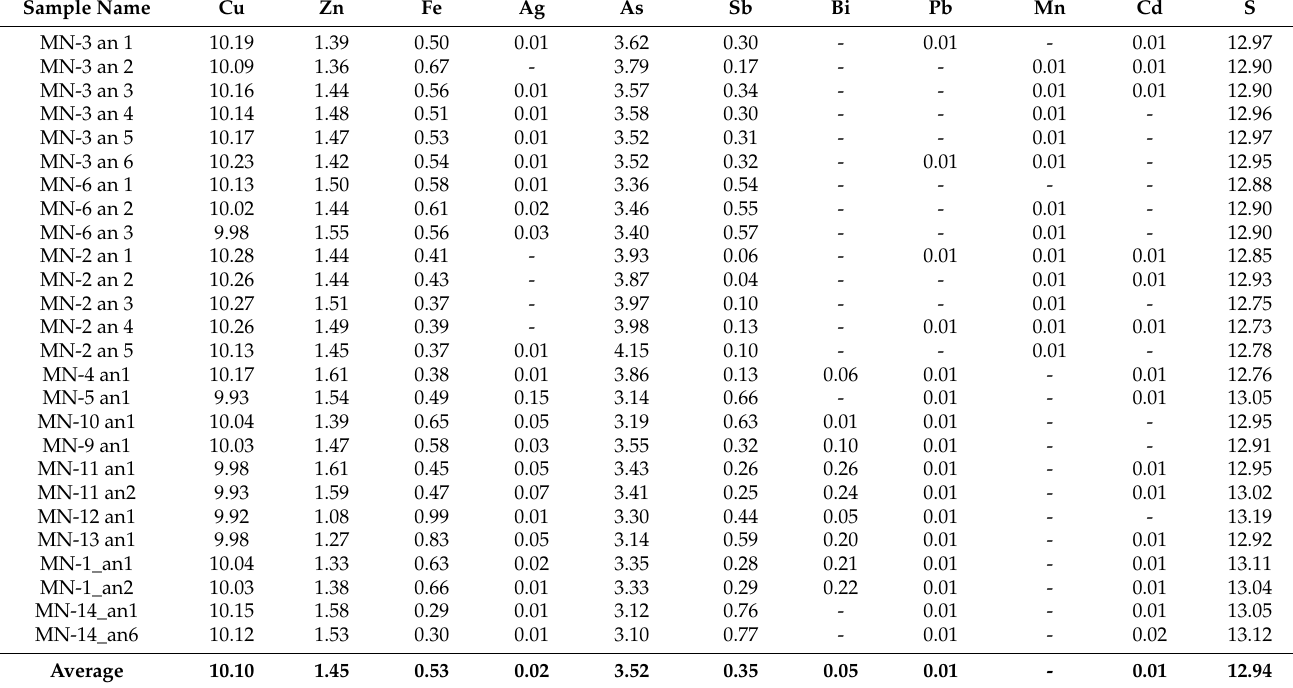
Table 7. Structural formulae calculated in atoms per formula unit ( apfu ) based on 29 atoms of